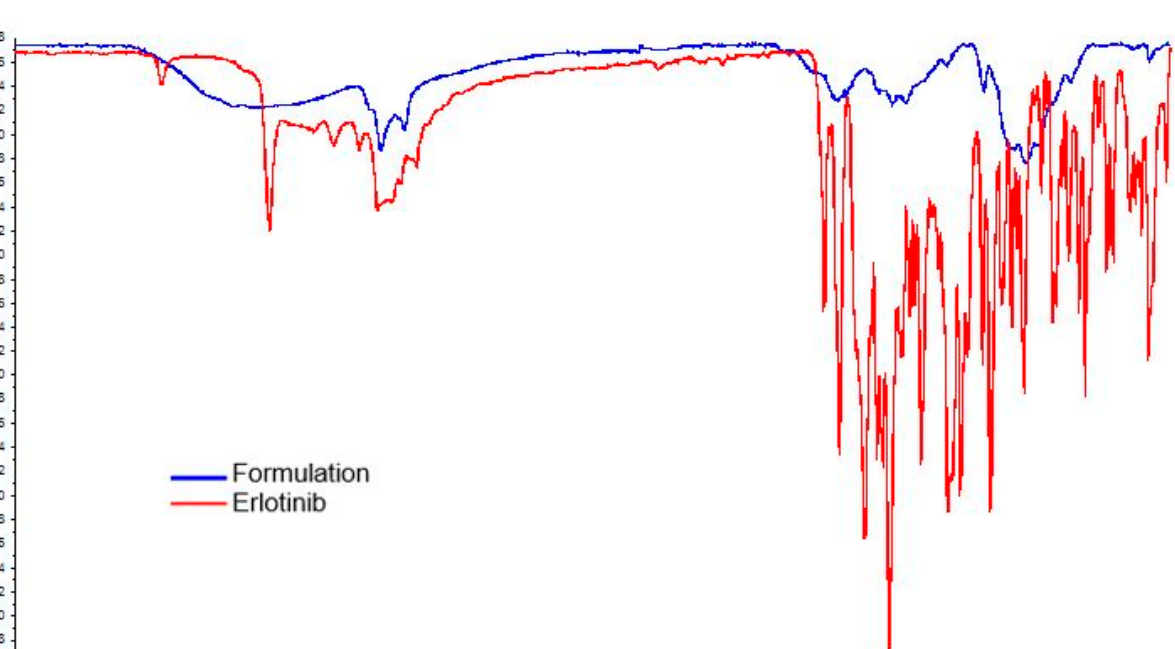
Figure A7. Chitosan Thermogram.